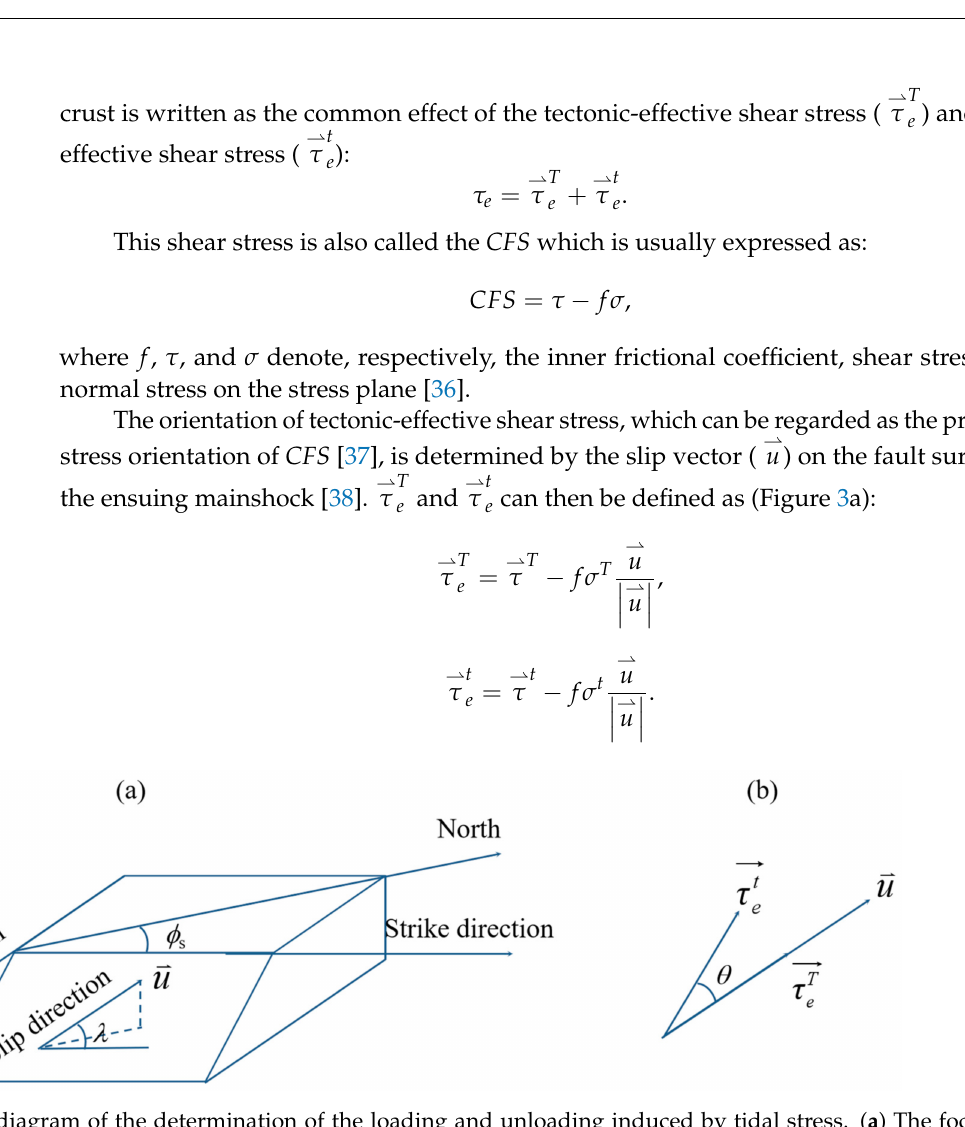
Figure 3. Schematic diagram of the determination of the loading and unloading induced by tidal stress. ( a ) The focal mechanism, ( b ) the relationship between the tectonic and tidal effective shear stresses. ϕ s : fault strike, δ : dip angle, λ : slip direction, θ : angle between the tectonic and tidal effective shear